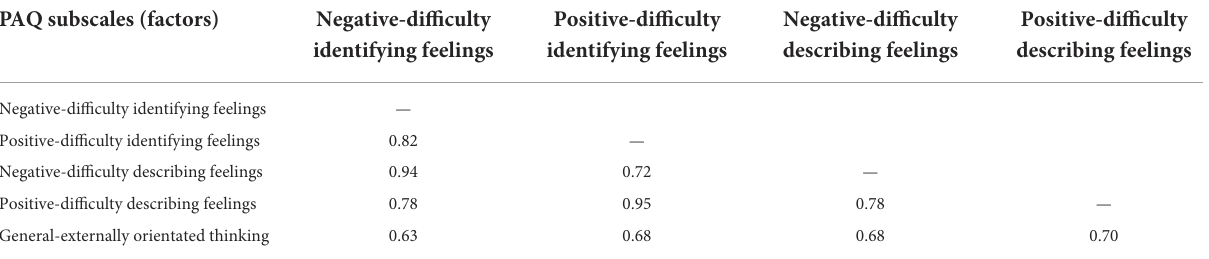
TABLE 4 Estimated correlations between the factors (subscales) of the 5-factor PAQ model (all p < 0.001). PAQ subscales